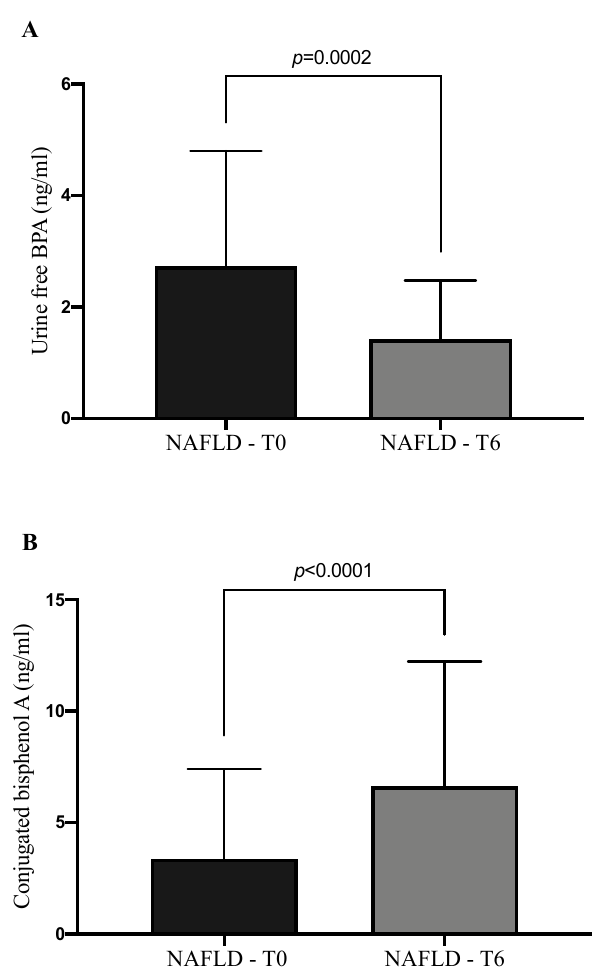
Figure 5. Free bisphenol A (BPA) and conjugated bisphenol A urine levels at the baseline and after six months of silybin with phospholipids and vitamin D (RealSIL 100D) administration (( A ) p = 0.0002; ( B ) p < 0.0001 respectively).